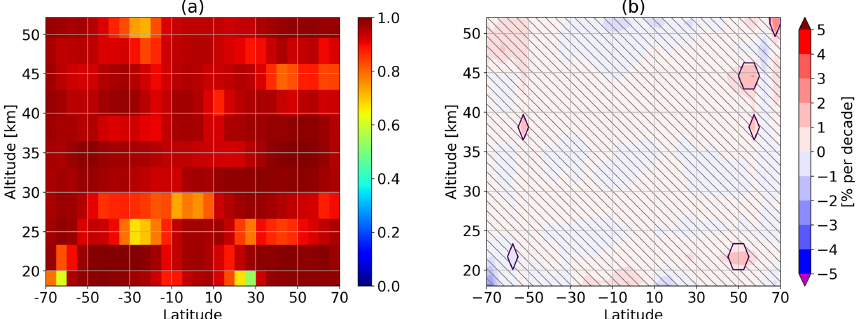
Figure 5. (a) Pearson correlation coefficient of the merged debiased data set with respect to MLS time series over 2005–2016. (b) drift of the merged debiased time series with respect to MLS in % per decade, (differences computed according to Eq. 3); dashed areas identify regions where the drift is not statistically